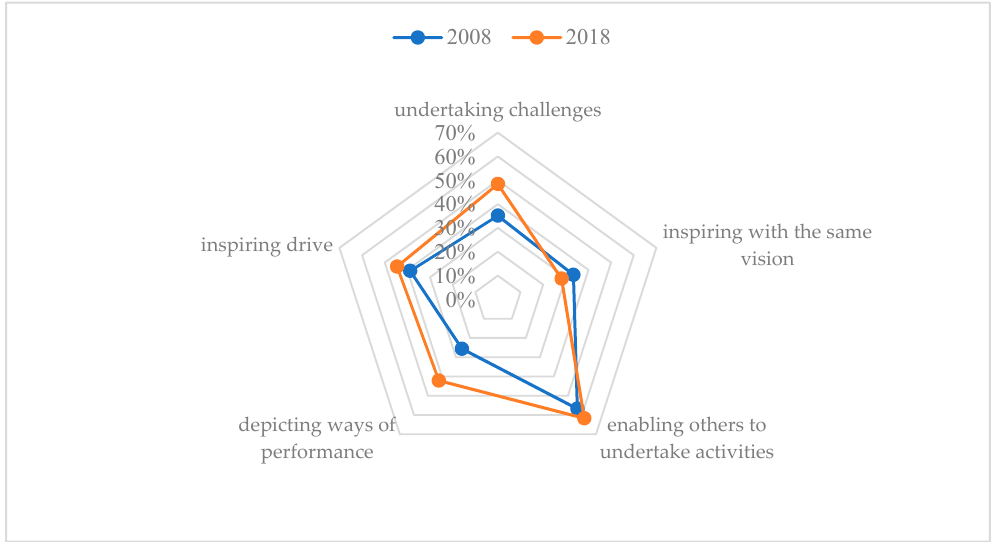
Figure 3. Evaluation of possibilities and areas in which leadership activity delegation is possible as assessed by leaders of the Forbes Global 2000 world’s largest corporations.